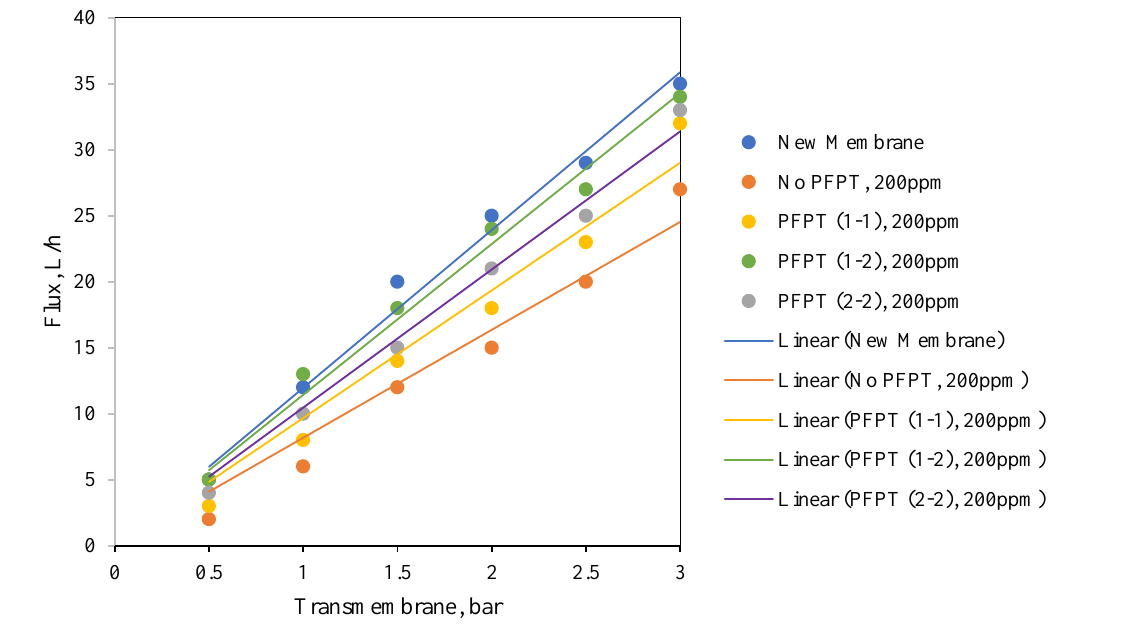
Figure A1. Permeability test at the end of each filtration process for feed of 100 ppm.